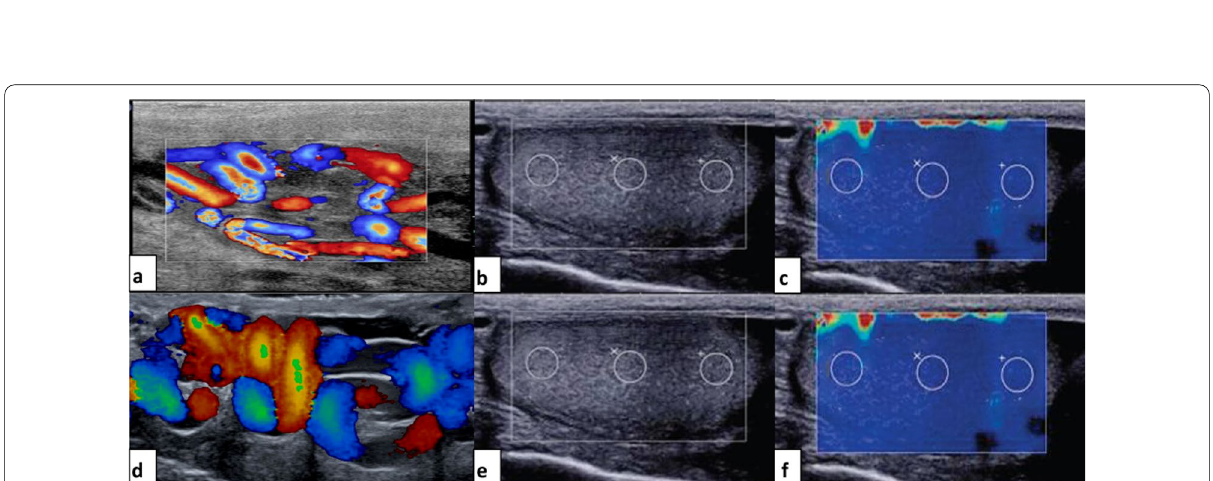
Fig. 2 A 43-year-old oligospermic patient with bilateral testicular varicocele. a Rt. testicular high-resolution ultrasound showed testicular varicocele (grade II). b , c Shear wave elastography of the Rt. testicle displayed homogenous blue color and increased mean testicular stiffness value d Lt. testicular high-resolution ultrasound showed testicular varicocele (grade III). e , f Shear wave elastography of the Lt. testicle displayed homogenous blue color and increased mean testicular stiffness value